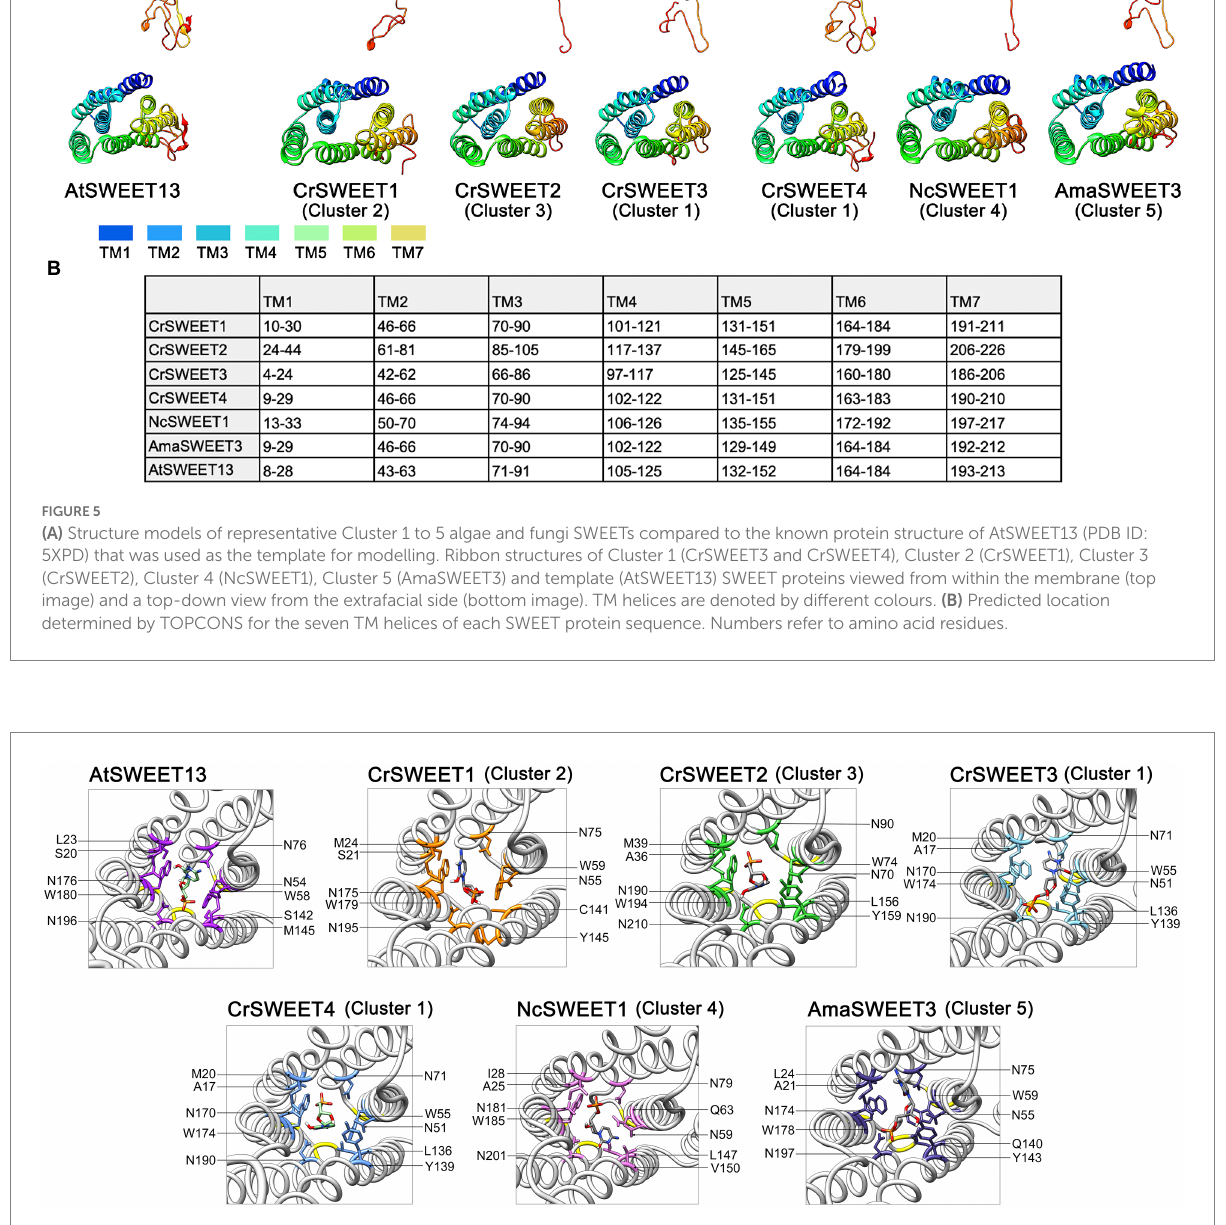
FIGURE 6 Predicted substrate binding site residues of CrSWEET1 to 4, NcSWEET1 and AmaSWEET3, compared with AtSWEET13. The DCM substrate surrounded by the binding pocket residues is shown. Residues were determined by alignment with the previously characterised binding site residues for AtSWEET13. The structures are viewed from the intrafacial/cytosolic side through the pore